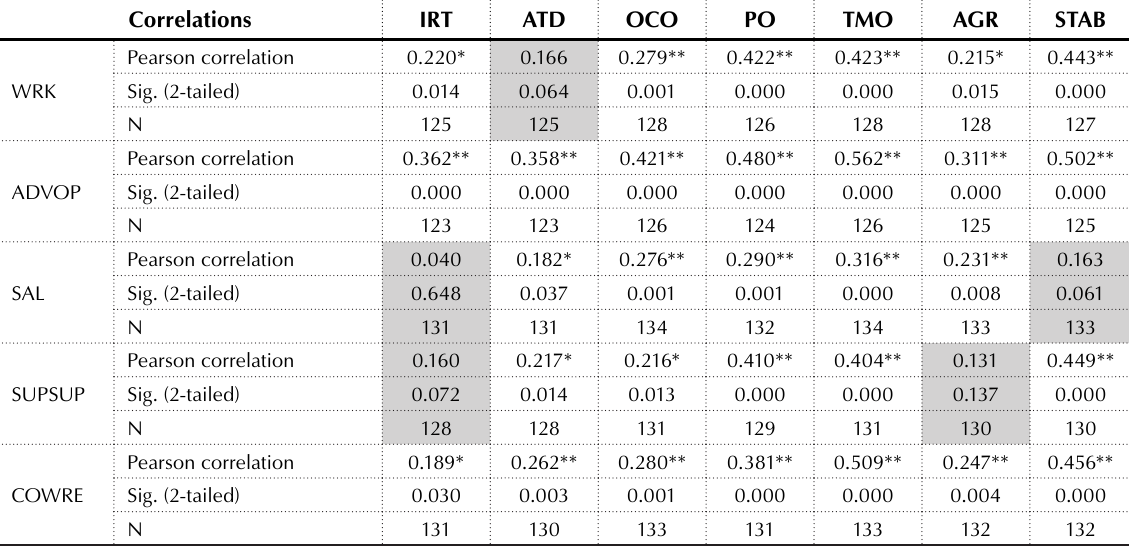
Table 3. Correlation of organizational culture and job satisfaction indices